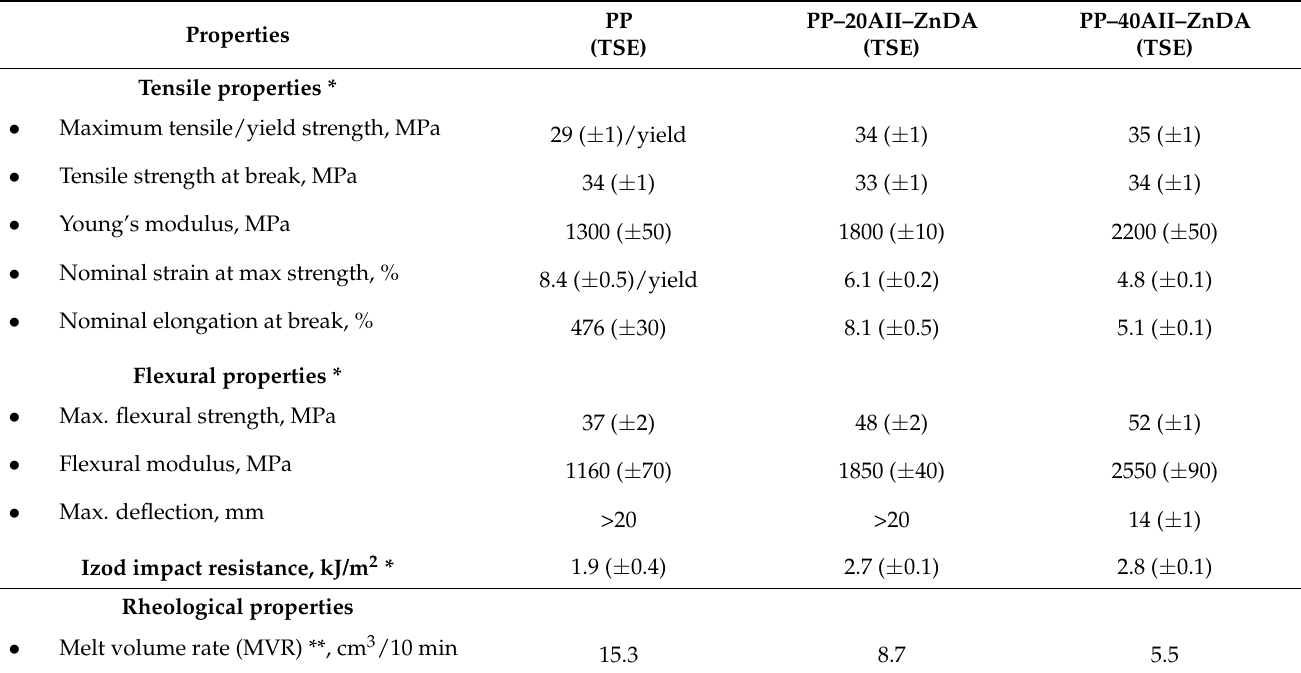
Table 4. Comparative properties of neat PP and PP filled with 20–40% AII and modified by